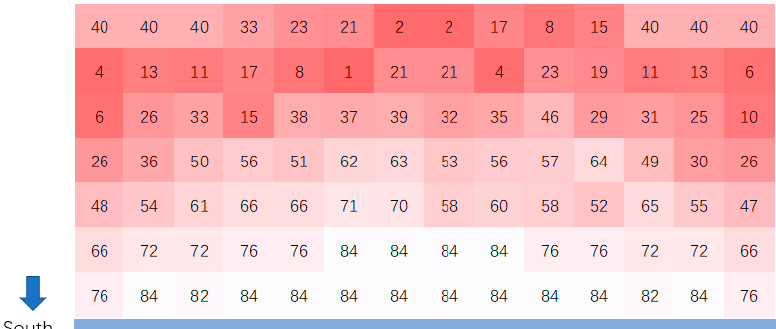
Figure 5. Prioritization of sensor location in the open-plan office space.